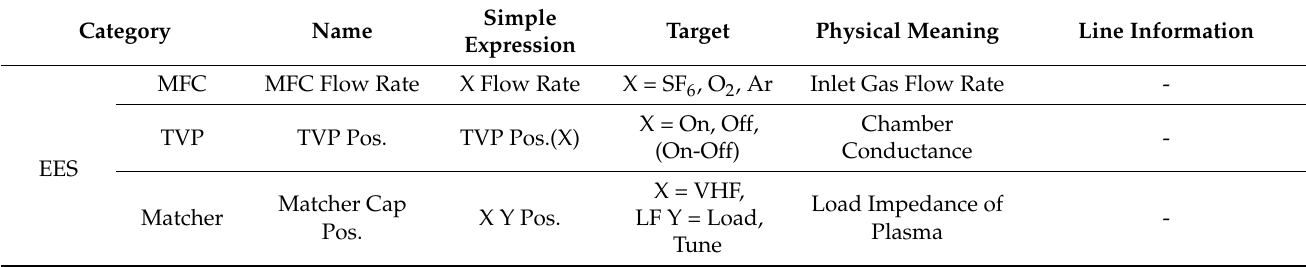
Table 2. Description of PI-VM input data. It is divided into EES, PI-OES, and PI Density . EES consists of MFC flow rate, TVP position, and matcher cap position. PI-OES consists of PI Single Line and PI Line Ratio , and PI Line Ratio is divided into PI Te and PI Density Ratio . PI Density is divided into PI Inlet Gas , PI Radical , and PI ne